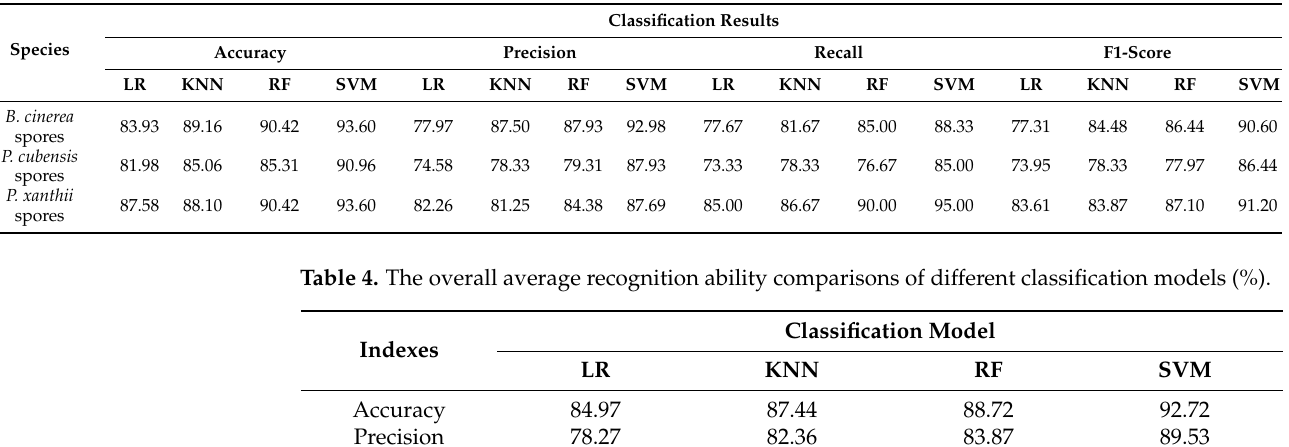
Table 3. Comparative analysis of different classification models (%).